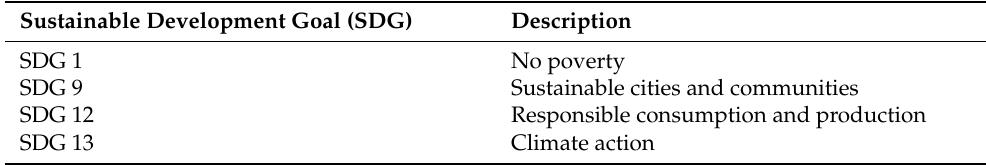
Table 1. Contribution of 3D printing to Sustainable Development Goals (SDGs). Sustainable Development Goal (SDG) Description SDG 1 No poverty SDG 9 Sustainable cities and communities SDG 12 Responsible consumption and production SDG 13 Climate